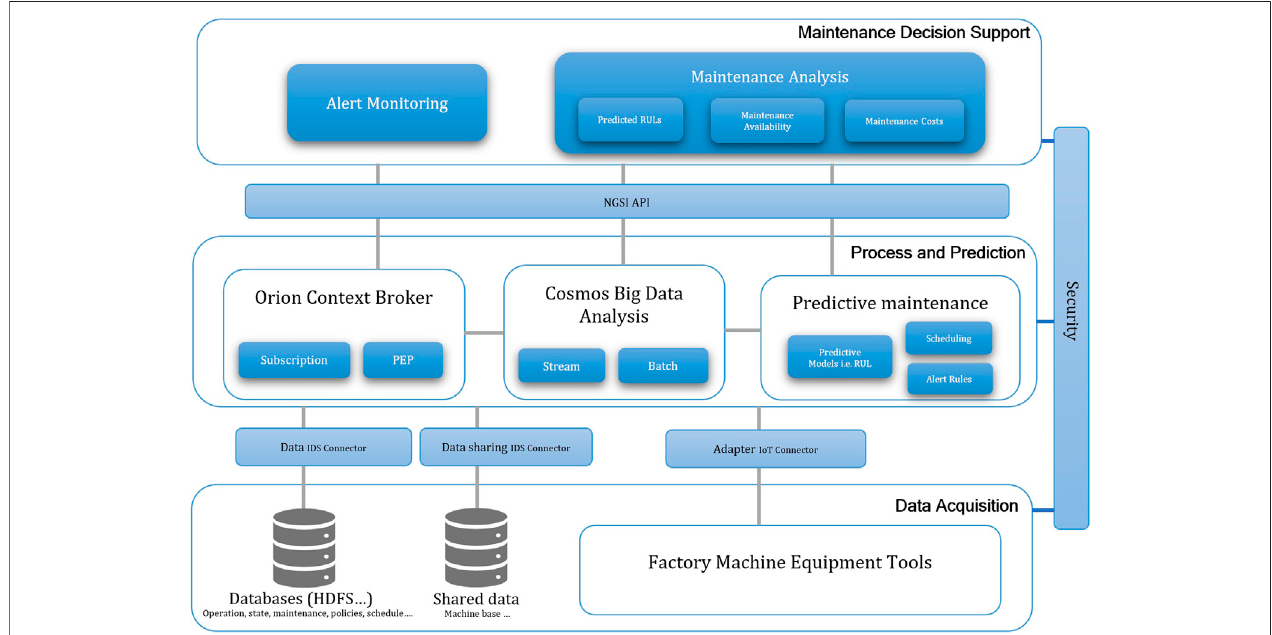
FIGURE 1 | PMMI 4.0 architecture based on